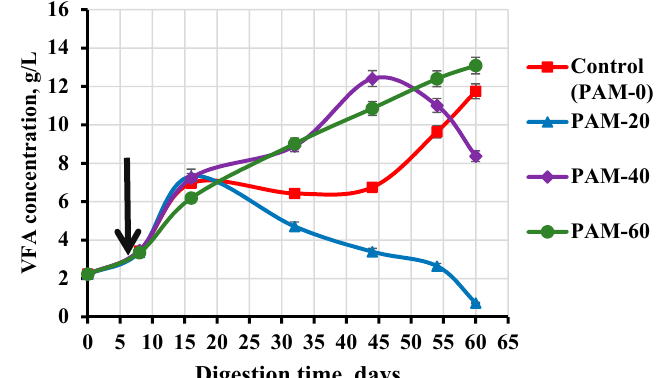
Figure 3. Dynamics of volatile fatty acids (VFA) accumulation and consumption (overall concen- trations of acetate, propionate, and butyrate, g/L): Control (polyacrylamide (PAM)-0) without the flocculant; PAM-20, PAM-40, and PAM-60, the flocculant concentrations 20, 40, and 60 mg/g total solids (TS), respectively. Time of the flocculant addition is indicated by the arrow. The concentration of total ammonia nitrogen (TAN) produced during digestion did not exceed 1.1 g/L, with the highest values in the samples PAM-20 and PAM-40 (Table 3).